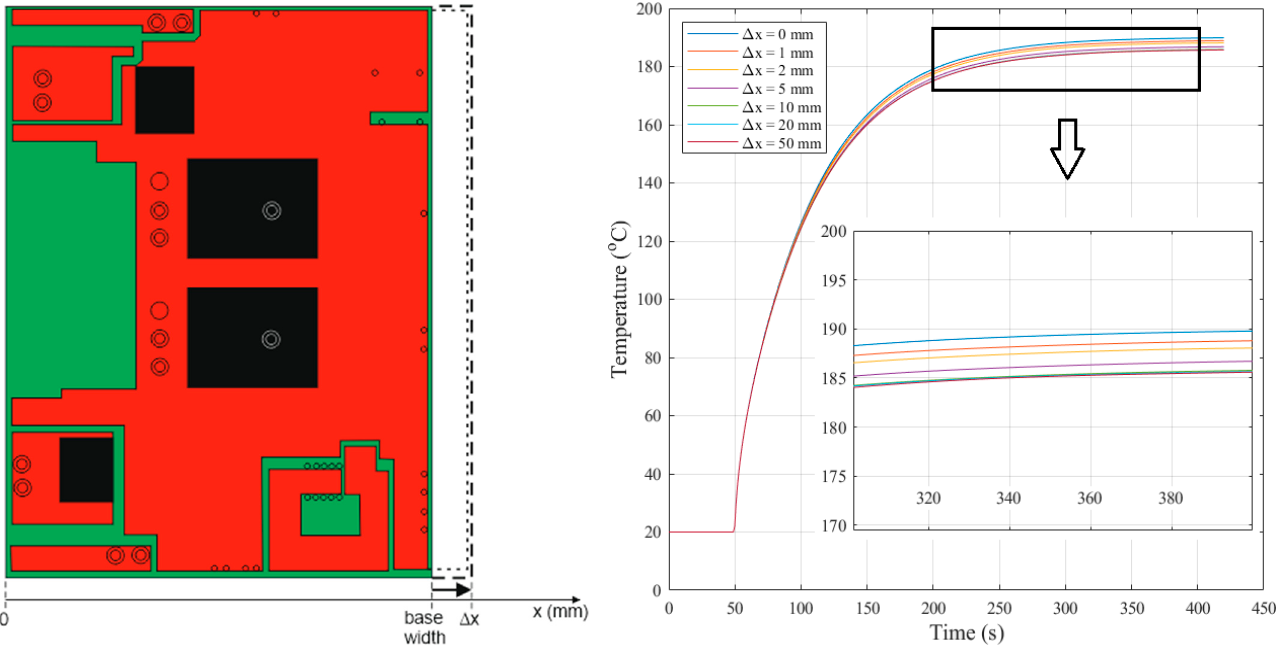
Figure 14. The regular PCB geometry with marked extension. Temperature transient of the hotspot (SP3) for different board sizes.